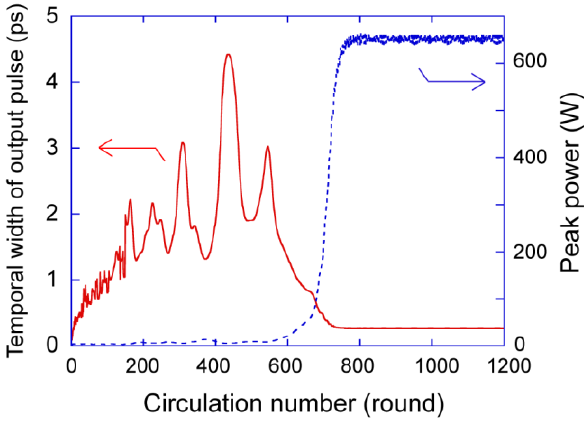
Figure 3. Variation of temporal width and peak power of output pulse for initial passive mode-locking process in soliton mode-locking regime ( D T = −0.05 ps 2